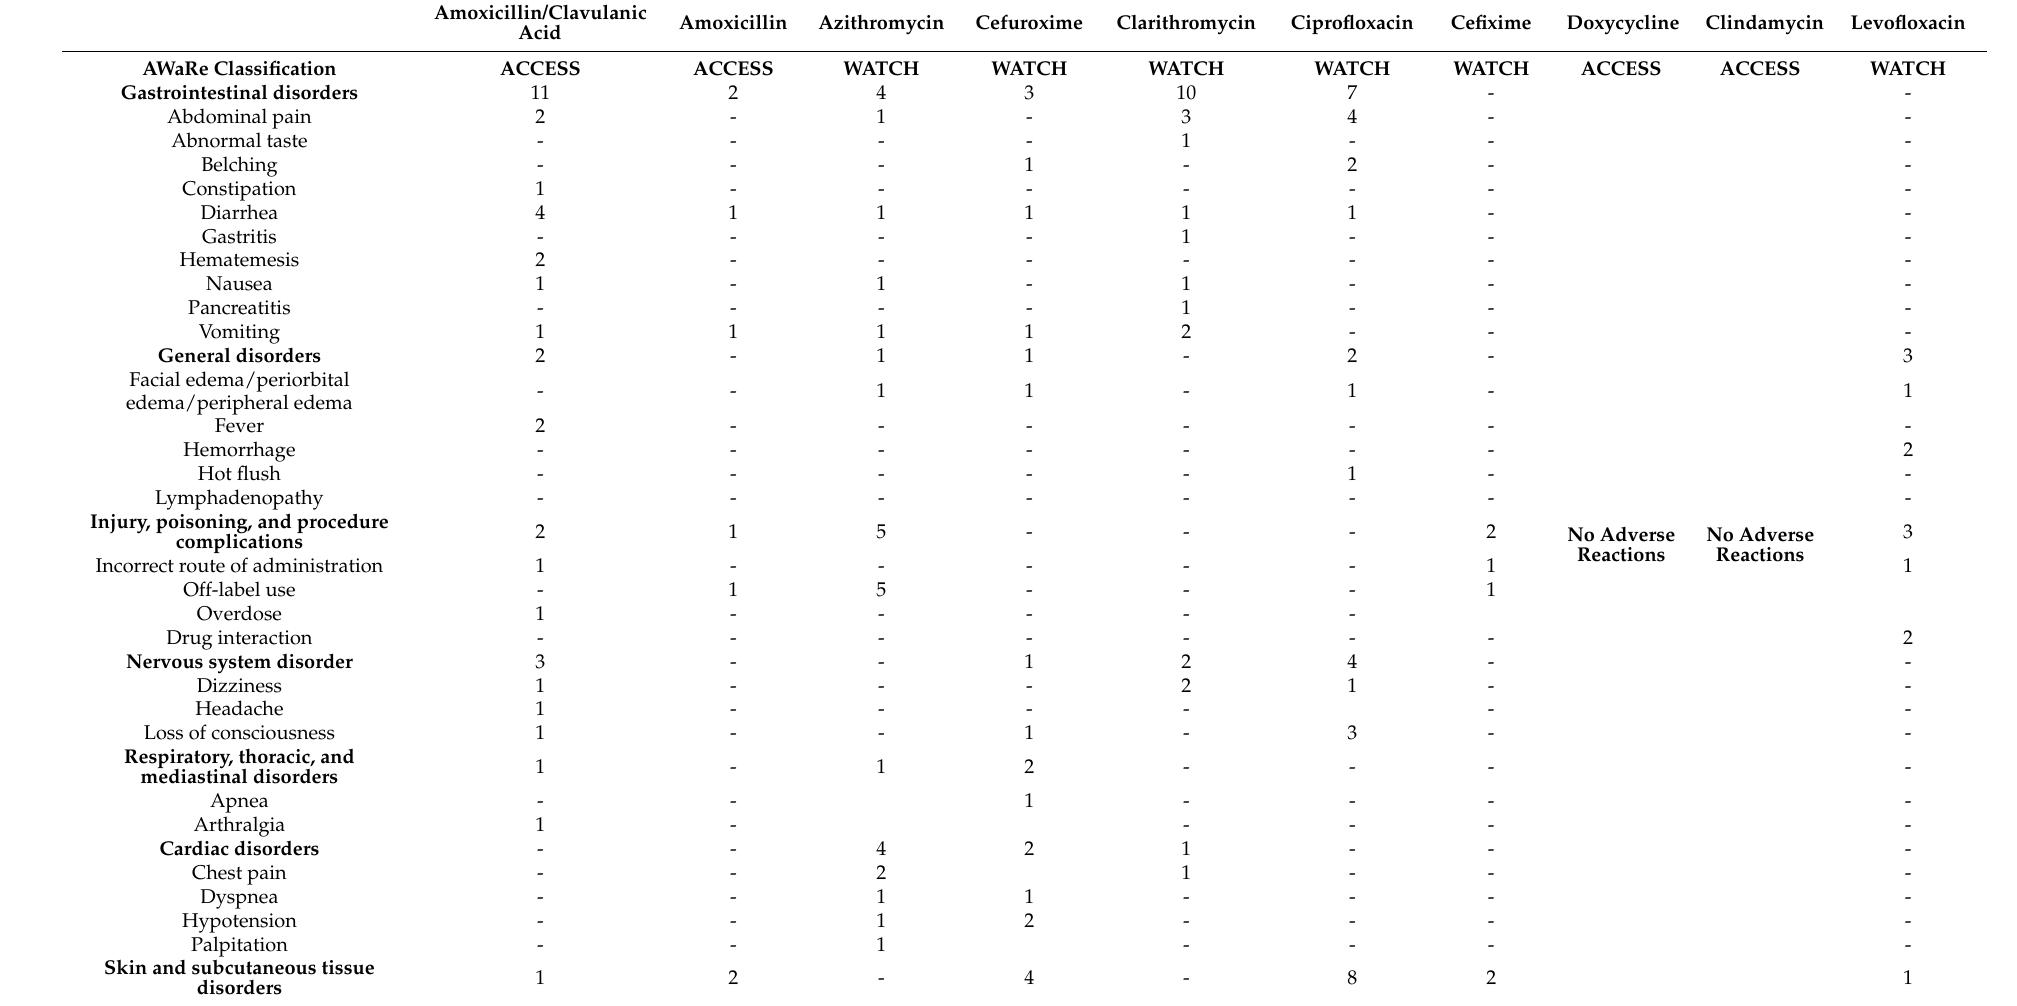
Table 6. Antimicrobial-related ADEs of the most consumed antibiotics in